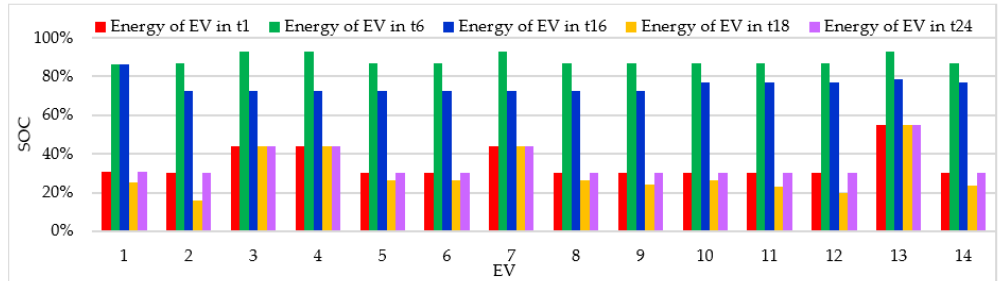
Figure 8. SOCs for the first 14 EVs, charging on weekend.